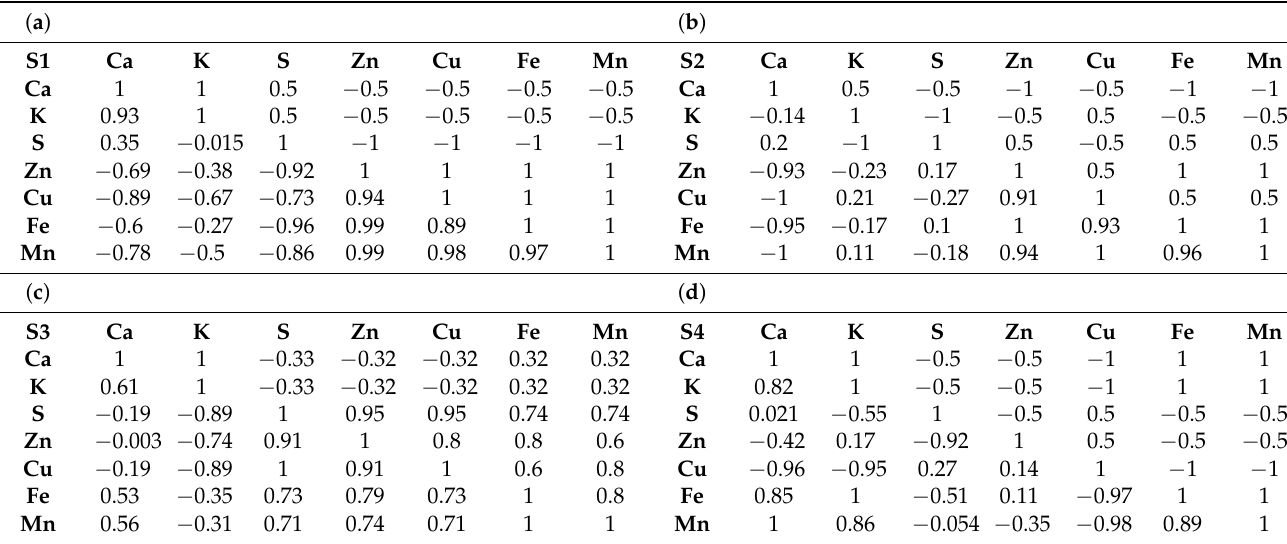
Table 3. Correlation matrices of Spearman (the top of the diagonal) and Pearson (the bottom of the diagonal) coefficients of mineral quantification of soils (Ca, K, S, Zn, Cu, Fe, and Mn) for soil